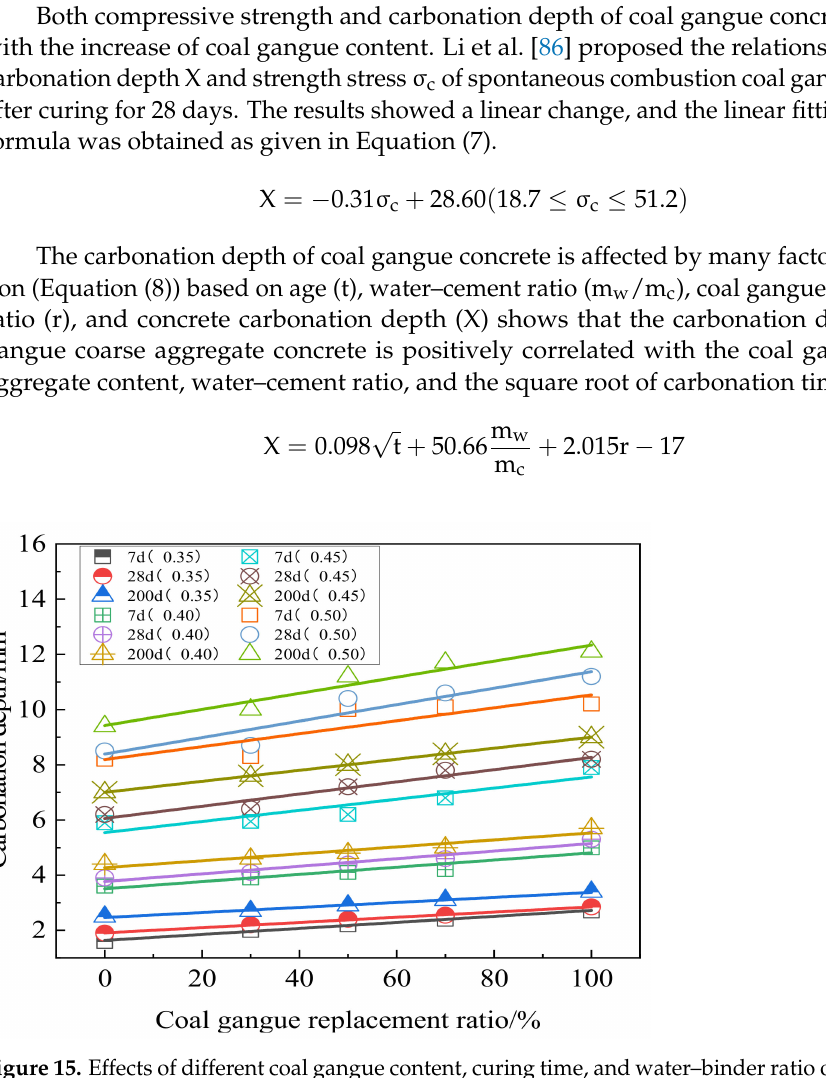
Figure 15. Effects of different coal gangue content, curing time, and water–binder ratio on carbonation depth of concrete